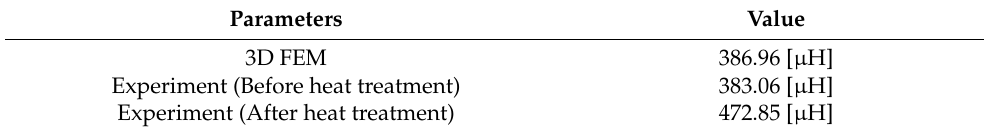
Table 3. Comparison of FEM and experiment inductance